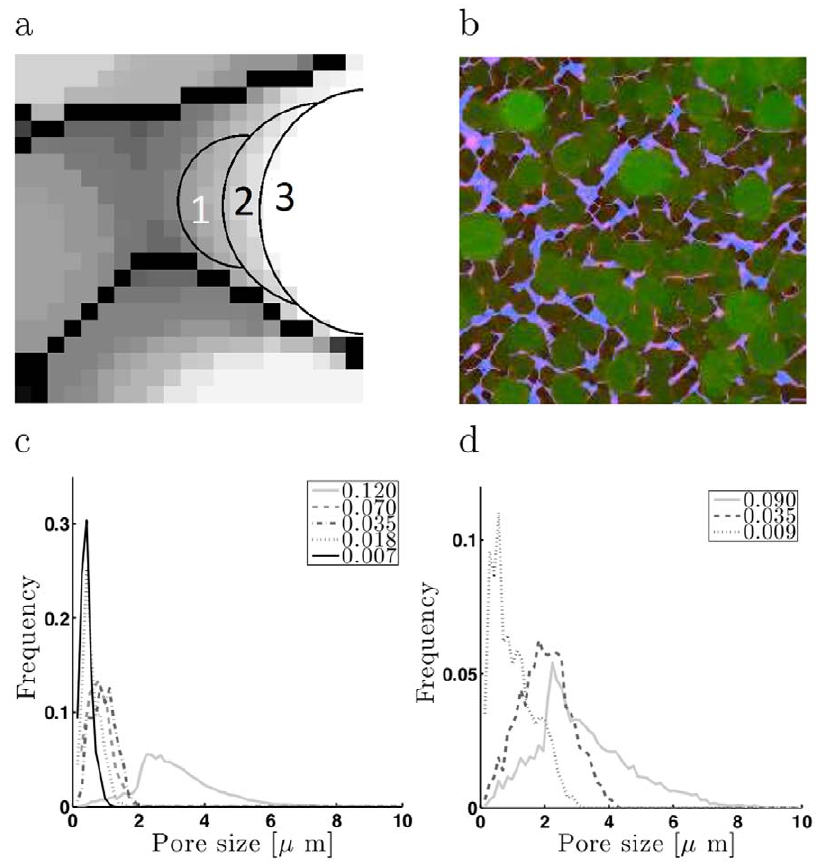
Figure 2. Pore-size analysis of actin networks. (a) Close-up illustration of the covering spheres method. Black pixels represent actin bundles, gray and white pixels represent covering spheres of three different radii. The thin black lines show edges of representative spheres. Here, sphere 1 is partially covered by a larger sphere 2, and sphere 2 is partially covered by sphere 3. The voxels enclosed by a sphere, but left uncovered by a larger sphere, are those counted for the pore size analysis. For example, the 19 voxels whose centers are in the crescent shaped region (2) would contribute to the total for pores of 12 pixel diameters because that is the diameter of sphere 2, and it is the largest such sphere which covers those voxels. (b) An example of the resulting pore size analysis using the covering spheres method. Red pixels are the original image, light blue pixels are a binary representation of the actin bundles. Green pixels are pixels from the covering spheres; the brighter the green the larger the pore size. Image is 29 m m along each side. (c) Pore size distribution of 10 m M actin networks for different R pa . (d) Pore size distribution for 20 m M actin networks for different R pa . Note that the higher concentration of crosslinkers leads to larger pore sizes.